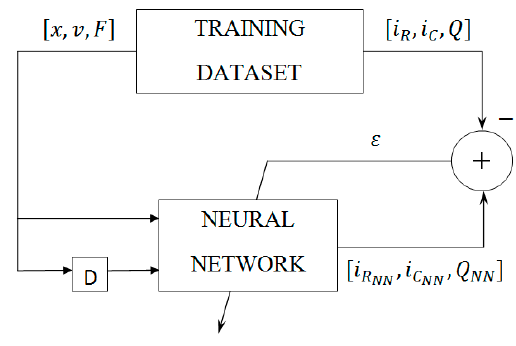
Figure 6. Time-delay neural network Figure 6. Time ‐ delay neural network training.